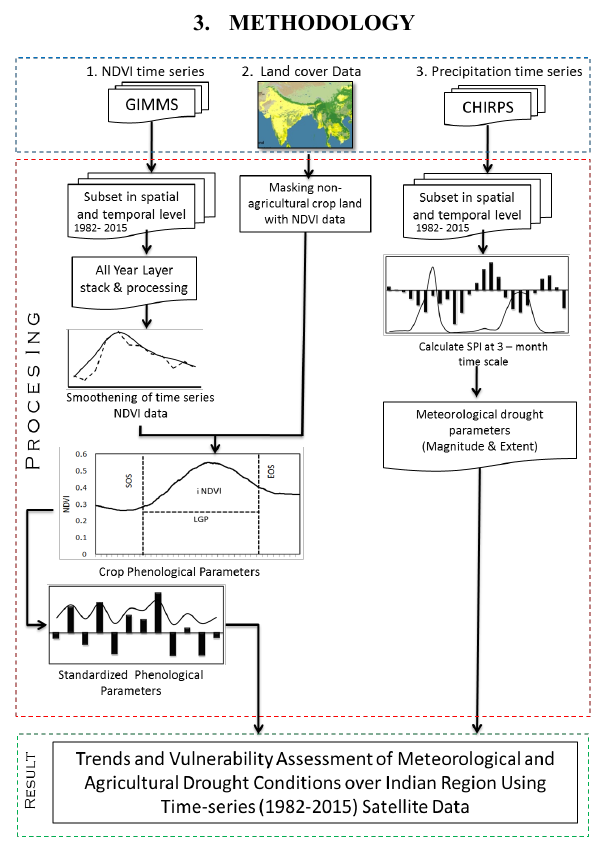
Figure 1 the schematic diagram of the overall methodology